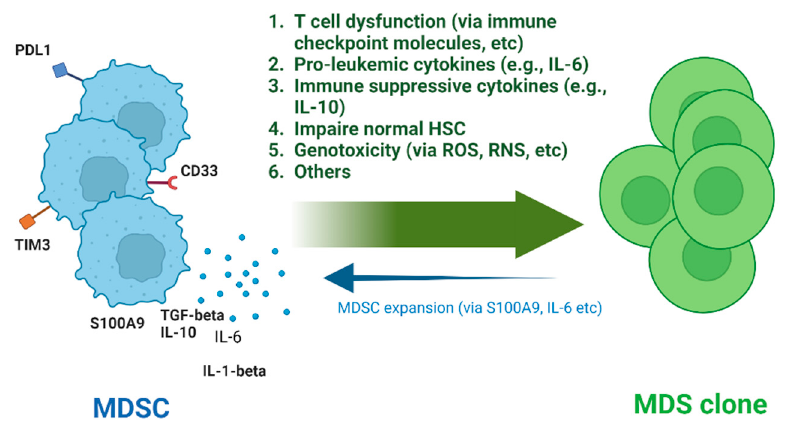
Figure 1. Pathogenetic roles of MDSCs in MDS. HSC, Hematopoietic Stem Cell; ROS, Reactive Oxygen Species; RNS, Reactive Nitrogen Species (Created with BioRender.com.)